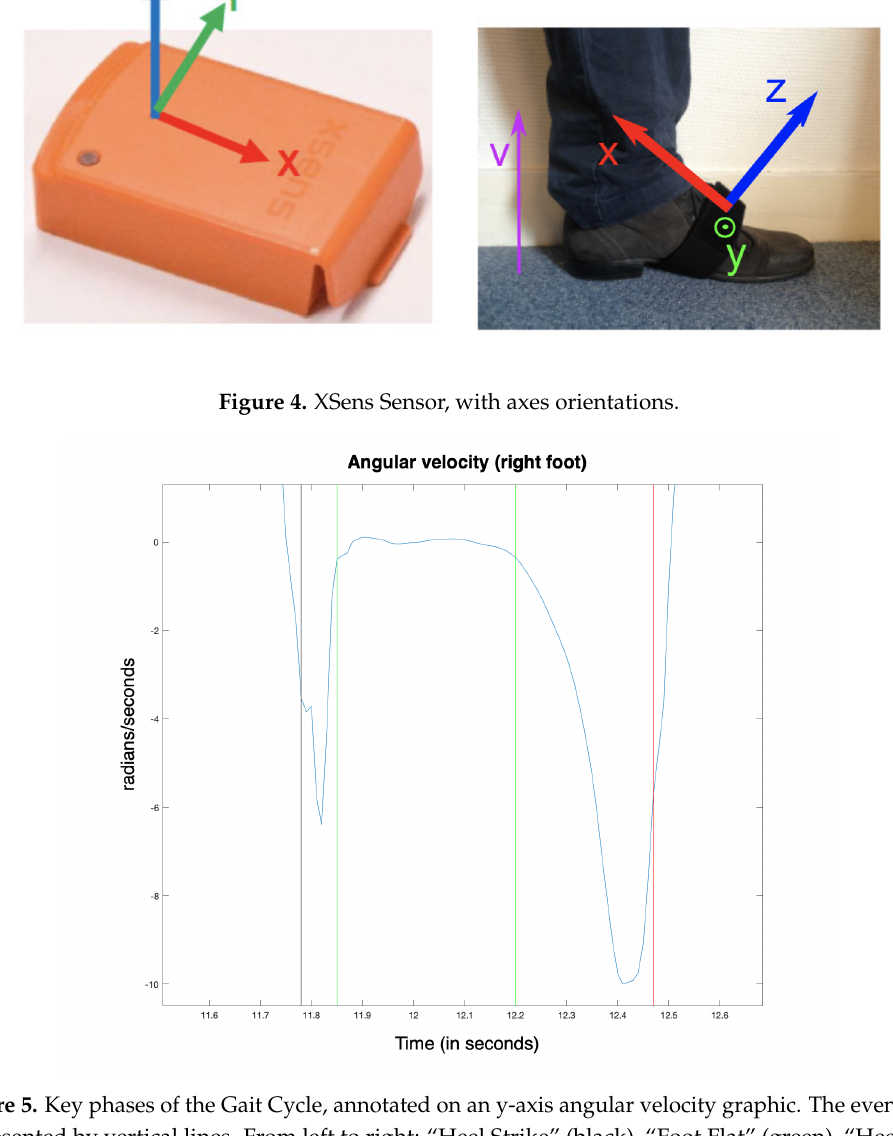
Figure 5. Key phases of the Gait Cycle, annotated on an y-axis angular velocity graphic. The events are represented by vertical lines. From left to right: “Heel Strike” (black), “Foot Flat” (green), “Heel Off” (green) and “Toe Off”